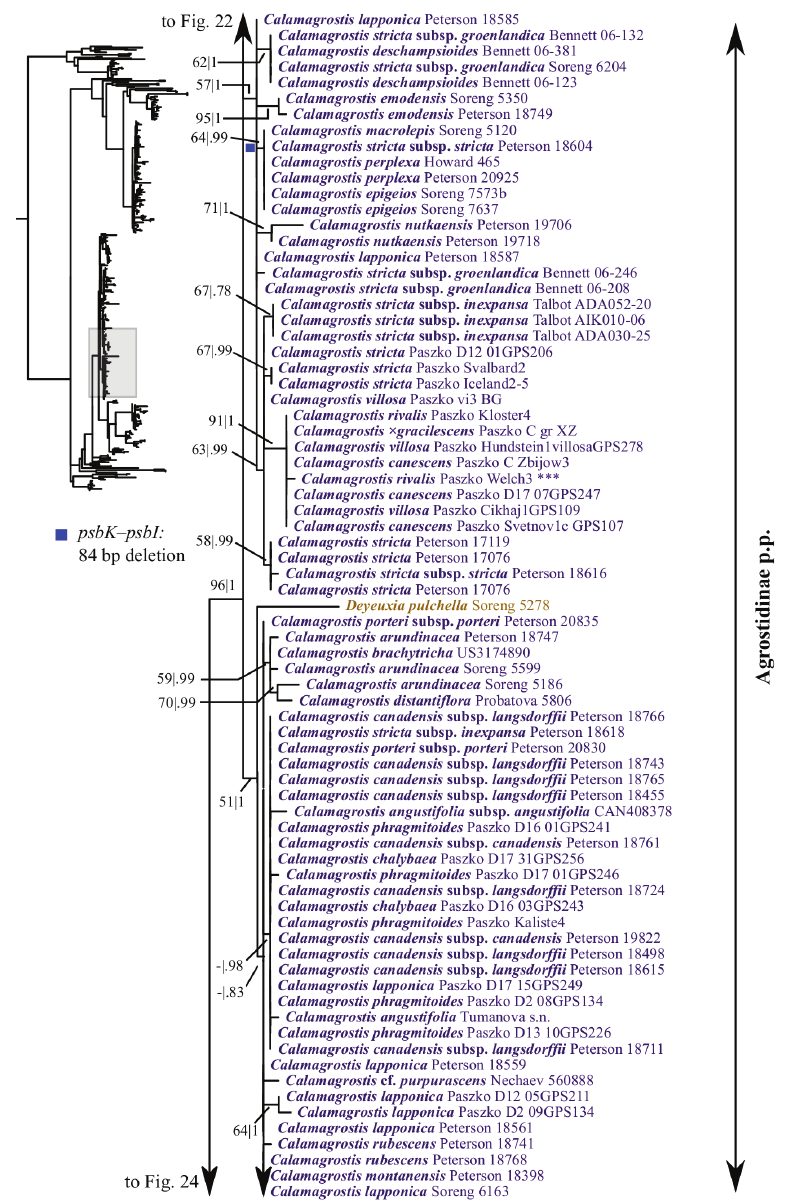
Figure 23. A portion (part of Agrostidinae p.p.) of the maximum likelihood phylogram inferred from combined plastid data ( atpF–atpH , psbK–psbI , psbA–rps19–trnH , matK , trnL–trnF ). ML bootstrap sup- port (left) and BI poster probabilities (right) are recorded along branches. A dash indicates bootstrap support <50%. No support is shown for branches with bootstrap support <50% and posterior probability <.5. The shaded area of the smaller tree on the left indicates the location in the overall tree of the portion shown. Placement of the sample with asterisks (***) is incongruent in nrDNA and plastid trees. An indel in psbK–psbI is mapped onto the